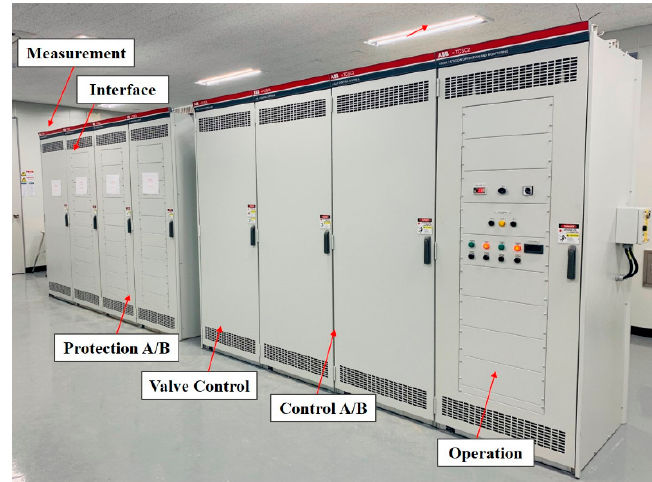
Figure 5. TCSC actual controller on-site.